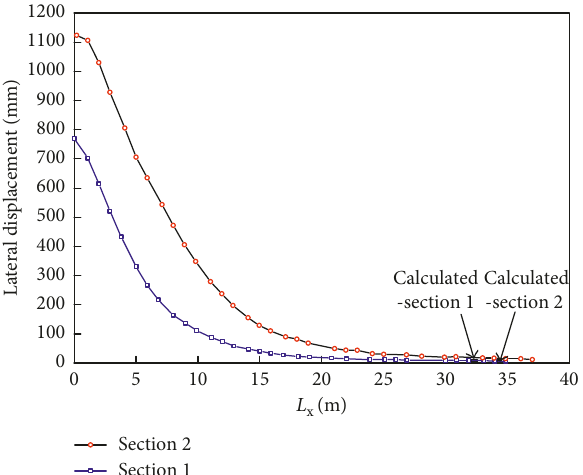
Figure 16: Variation of surface lateral displacement in the affected